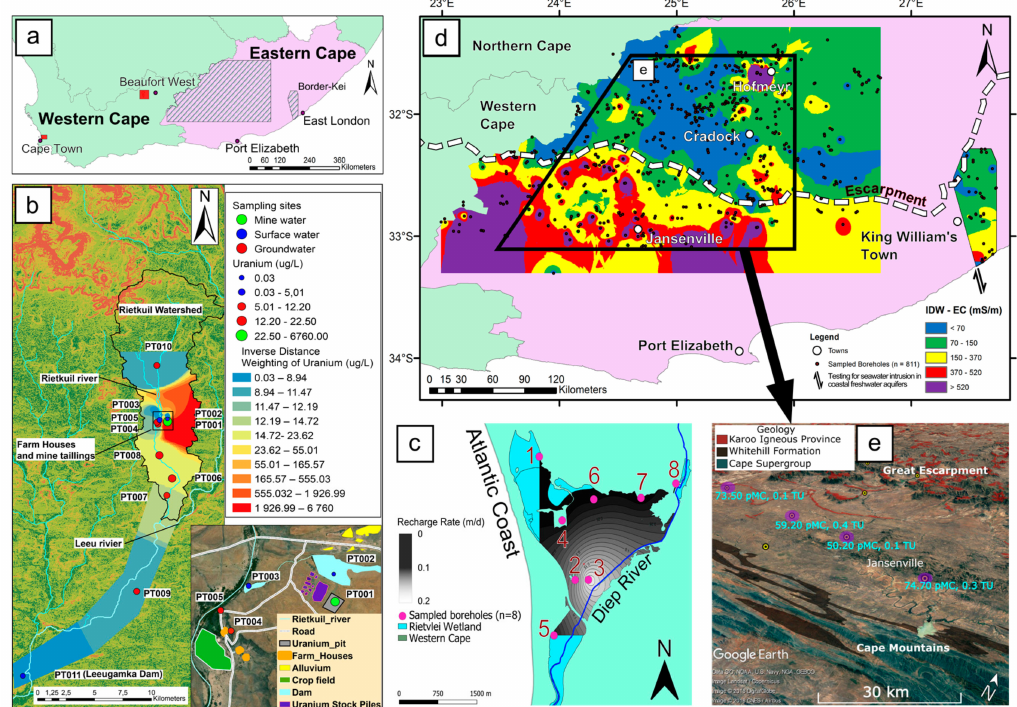
Figure 9. Mapping surface and ground waters of southern South Africa: ( a ) Location map of these baseline studies (hatched areas) and the two testing sites (red boxes); ( b ) measured Uranium (U) concentration levels along the Rietkuil drainage near Beaufort West, with a satellite image showing the mined pit, stockpiles, and farmhouses; ( c ) groundwater recharge map of a wetland at Rietvlei, near Cape Town; ( d ) interpolated Electrical Conductivity (EC) measurements of groundwater in the southern Karoo; and ( e ) isotopes signatures in groundwater samples (purple circles) near Jansenville that show mixing of old / deep saline waters with recent / shallow freshwaters (pCM = Percent Modern Carbon; TU = Tritium